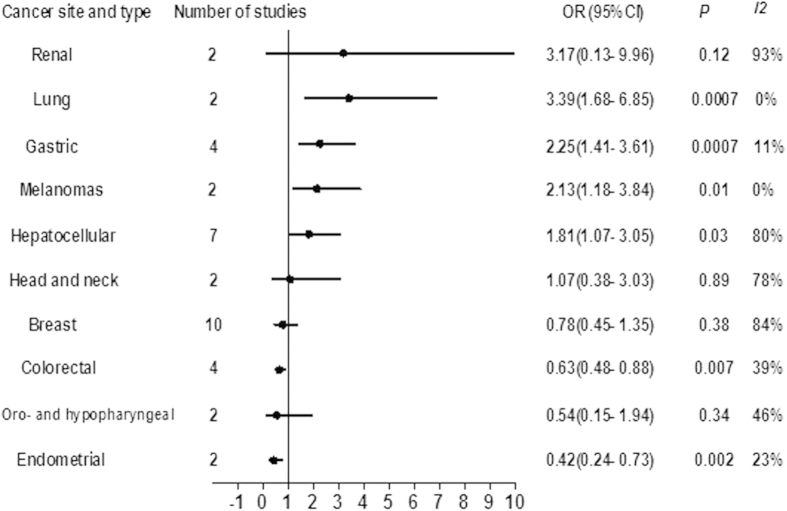
Summary risk estimates of disease-free survival (DFS) by cancer sites.